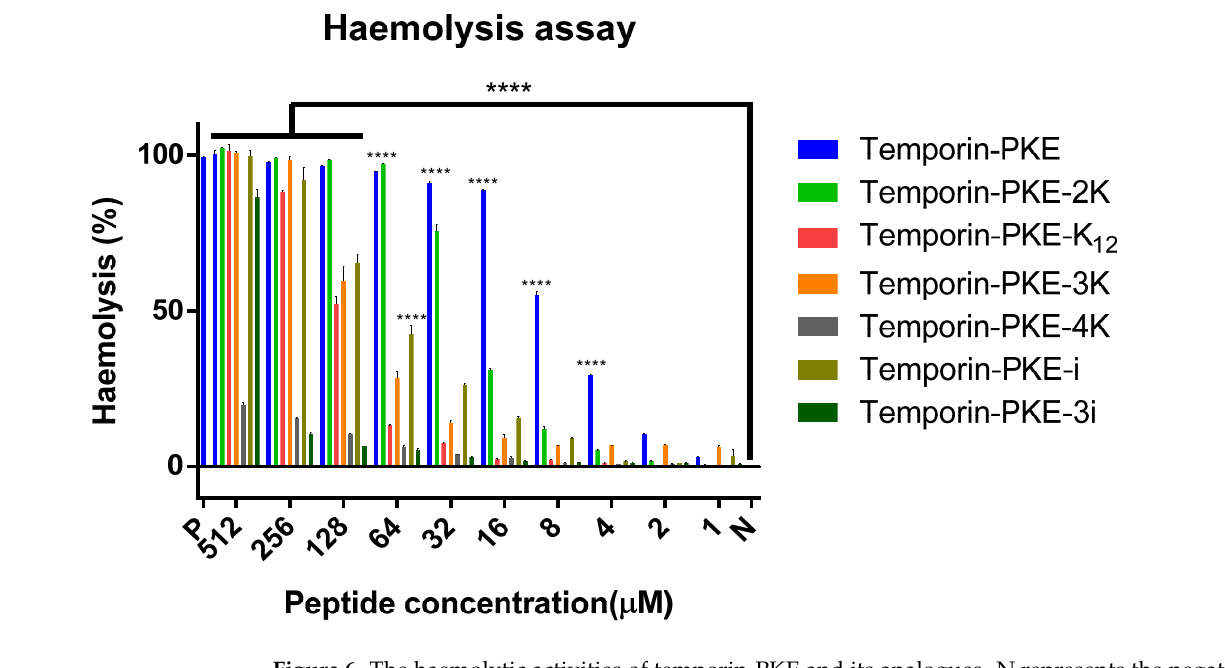
Figure 6. The haemolytic activities of temporin-PKE and its analogues. N represents the negative control and P represents the positive control, PBS and 0.1% Triton X-100 in this experiment, respec- tively. The results were analysed by two-way ANOVA and Dunnett’s multiple comparisons test that compared haemolysis of various concentrations of peptides with the negative control group. The significance is indicated by ****, which represents p < 0.0001. The error bar represents the SEM of the nine replicates from three independent tests.